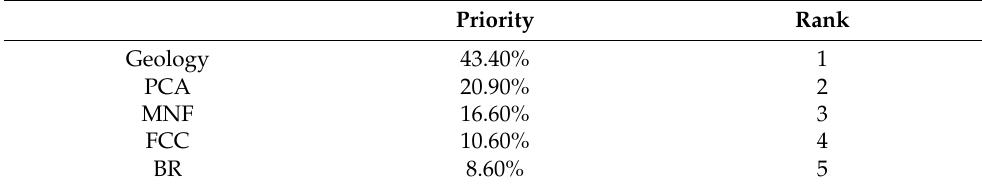
Table 5. Percentage and importance of information layers.